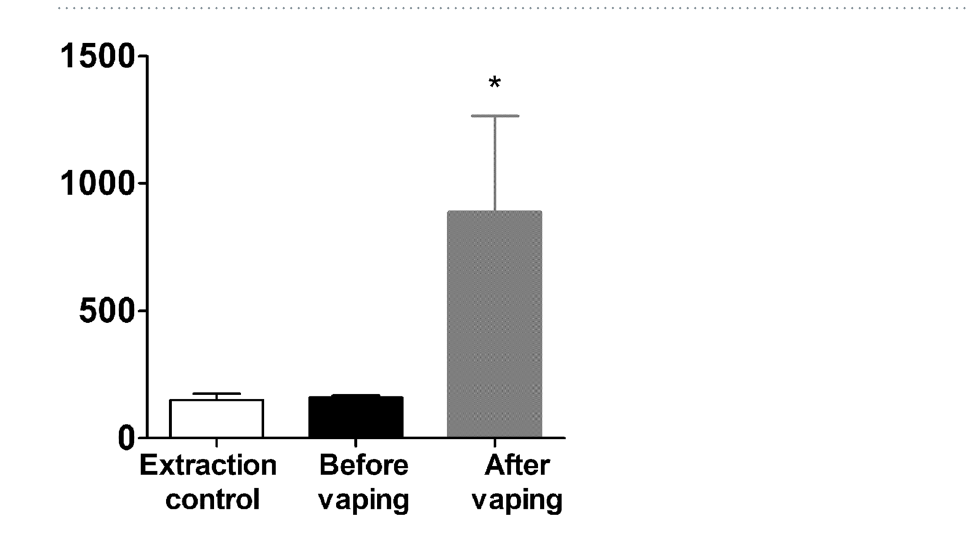
Figure 7. Detection of e-cigarettes third-hand smoking deposition. ( A ) E-liquid flavor Grape! was vaped 10 times (70 mL puffs, 100 W) onto a sheet of aluminum foil and deposition was collected and extracted in DMSO. Fluorescence (ex: 350 nm, em: 410 nm) after vaping was higher than before vaping ( * p <